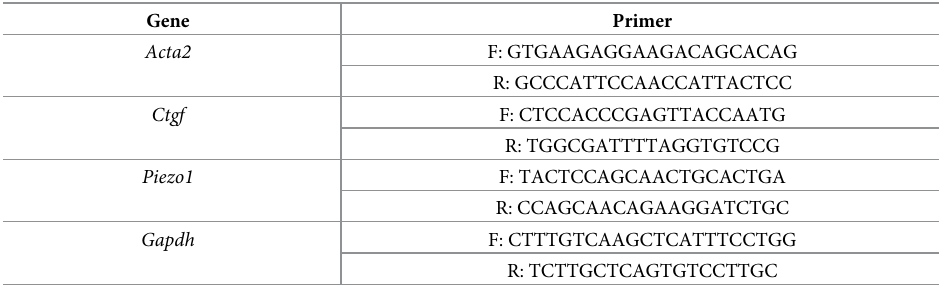
Table 1. Primers used for gene